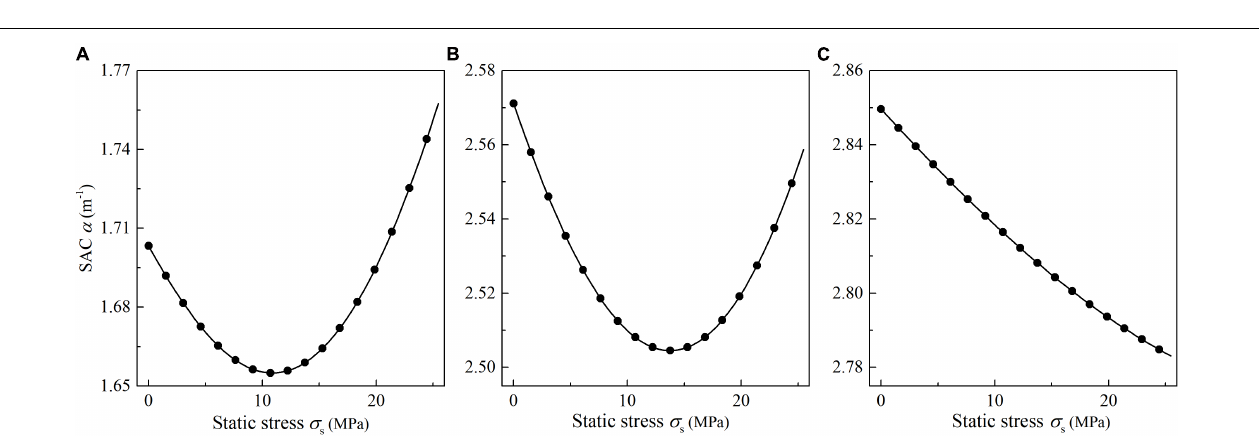
FIGURE 11 | Comparison of variation in the spatial attenuation coefficient versus the static stress ( x = 0.2 m, r 0 = 0.025 m, r L = 0.09 m, ω = 628.3 Hz) (A) Concave rock bar; (B) Straight rock bar; (C) Convex rock bar.